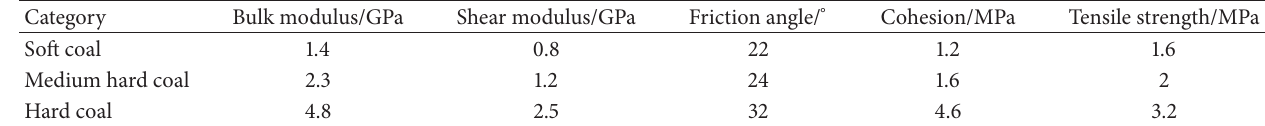
Table 3: Mechanical parameters for the coal of different category.